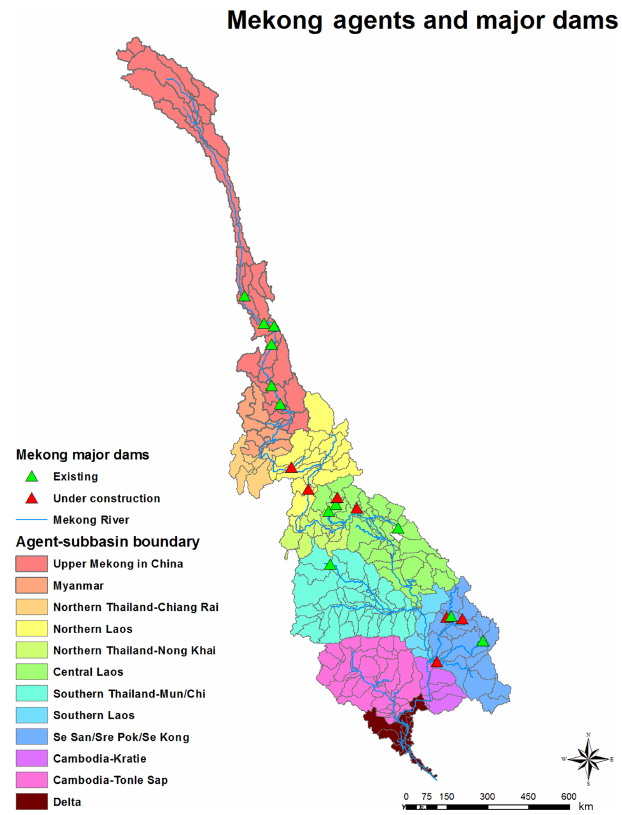
Figure 3. Basin map for the Mekong River basin showing agent boundaries and major dams included in the model.